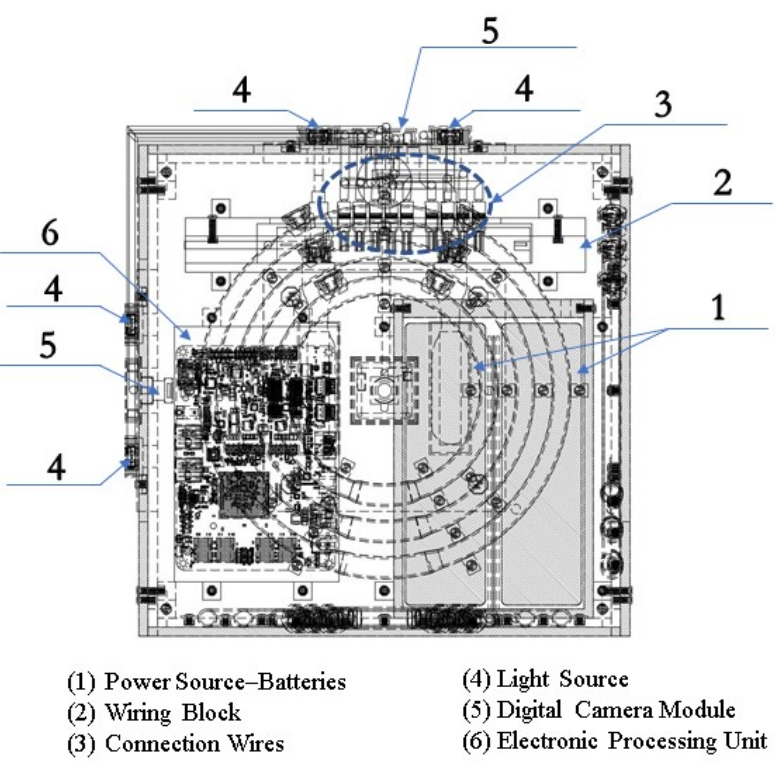
Figure 7. Back section of a PIVG.